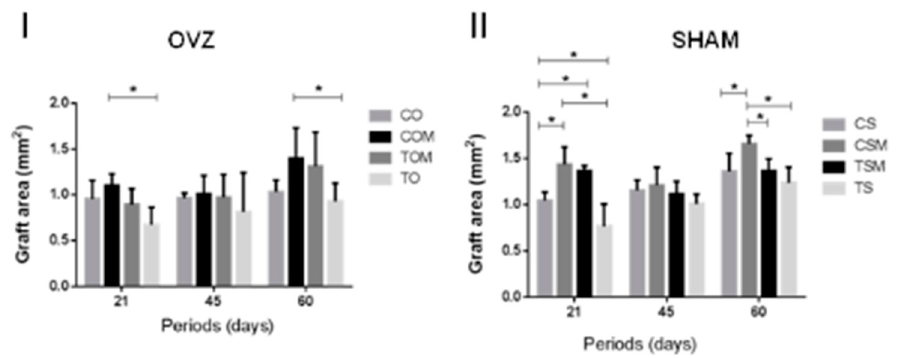
Figure 3. Means and standard deviations for graft area to OVX subgroups ( I ) and SHAM subgroups ( II ). * Statistically significant differences ( p < 0.05).